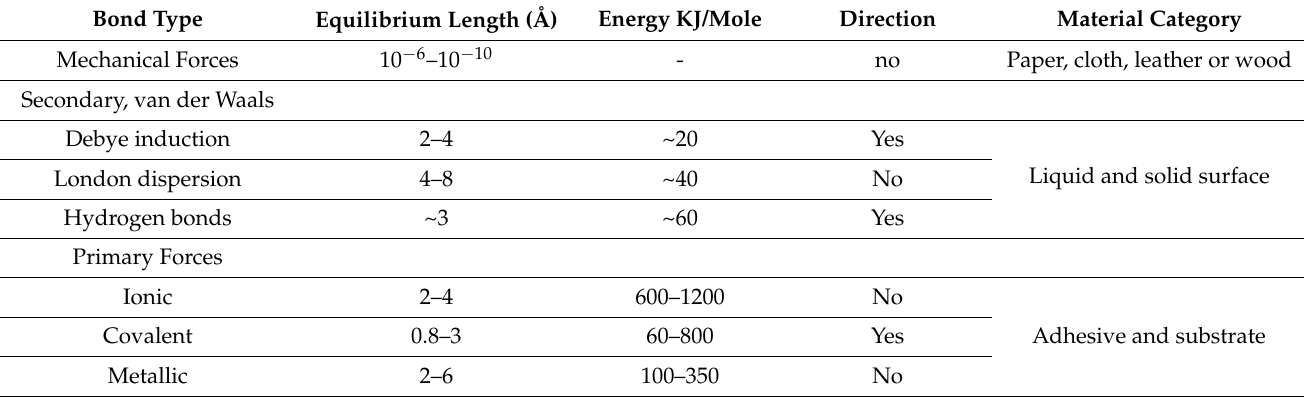
Figure 2. Normalized drag relationships for various forms of precipitation shapes based on data reported in various theories and fits [1]. Reprinted from [8] with permission from Elsevier. Table 1. Types of various forces on adhesive bonds.